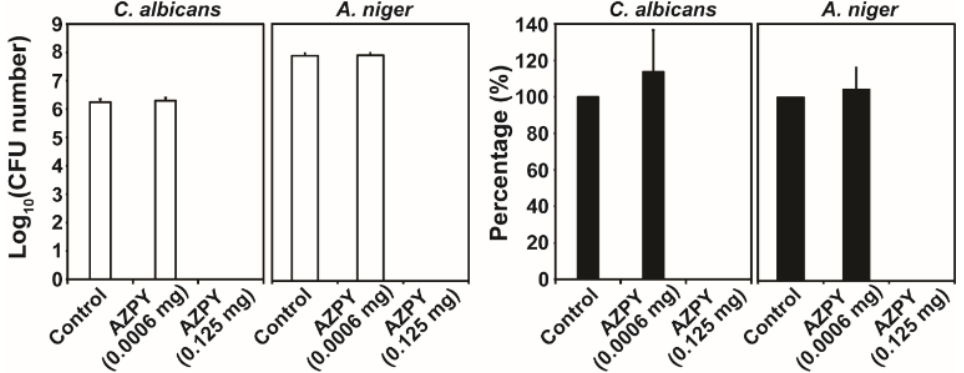
Figure 7. Effect of 4,4 ′ -azopyridine (AZPY) on the viability of C. albicans and A. niger . Fungal viability indicated as Log 10 (CFU number) and relative percentage after treated with the amount of AZPY released into media (0.0006 mg/mL) or the half amount (0.125 mg/mL) of inactivation concentration (0.25 mg/mL) of Cu(AZPY)-MOF for 1 day. The number of replicate measurements in the analysis was as follows: 9 replicates for C. albicans and 12 replicates for A. niger in the control and 0.0006 mg AZPY treatment; 3 replicates for both C. albicans and A. niger in the 0.125 mg AZPY treatment.